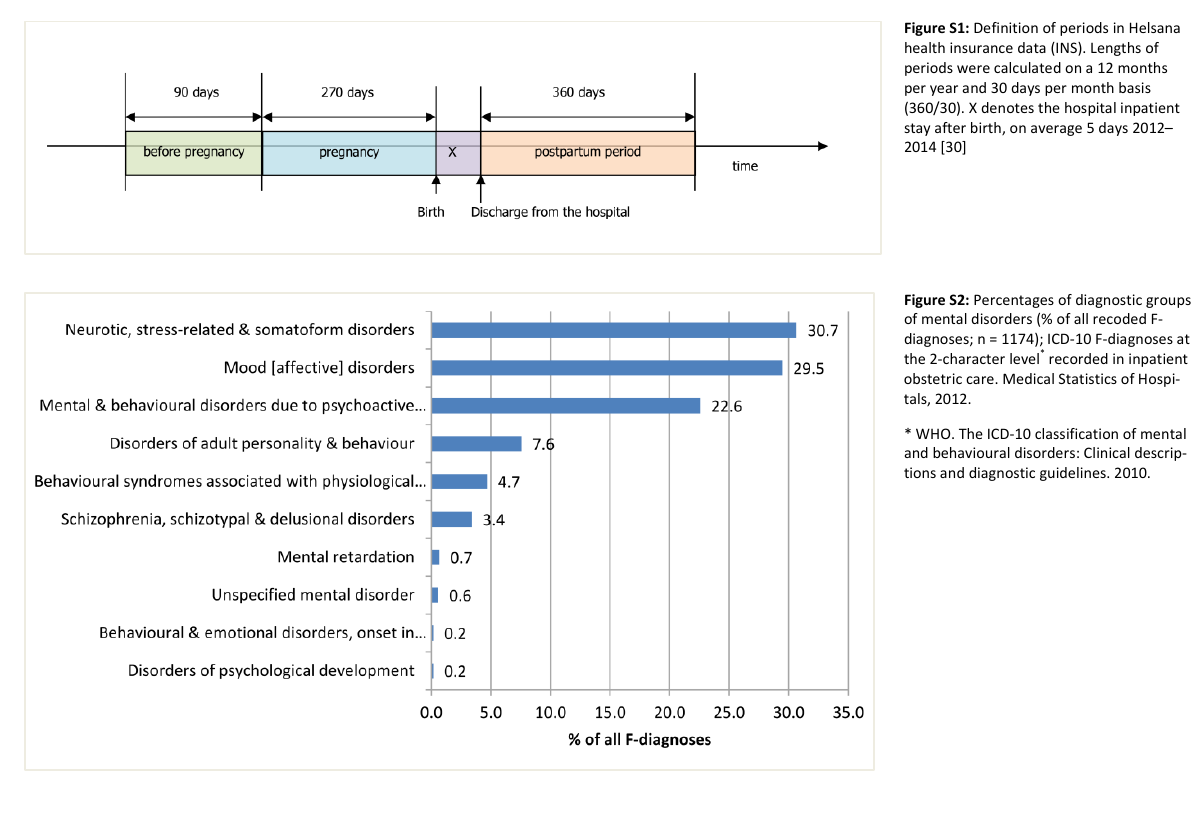
Figure S1: Definition of periods in Helsana health insurance data (INS). Lengths of periods were calculated on a 12 months per year and 30 days per month basis (360/30). X denotes the hospital inpatient stay after birth, on average 5 days 2012–